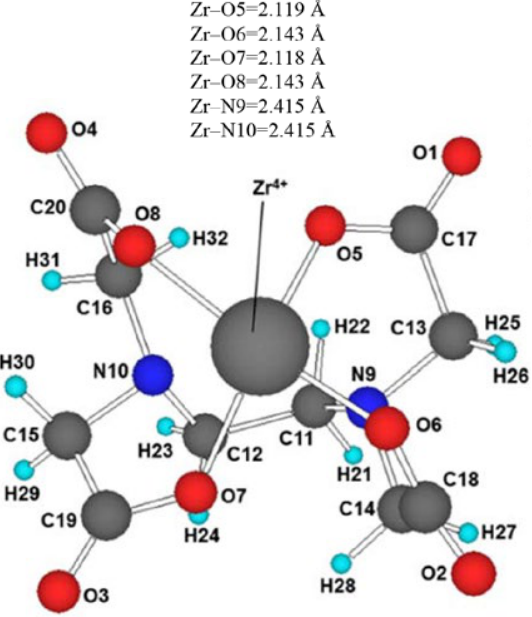
Fig. 7. Optimized structure of the most stable Y–EDTA (P5)